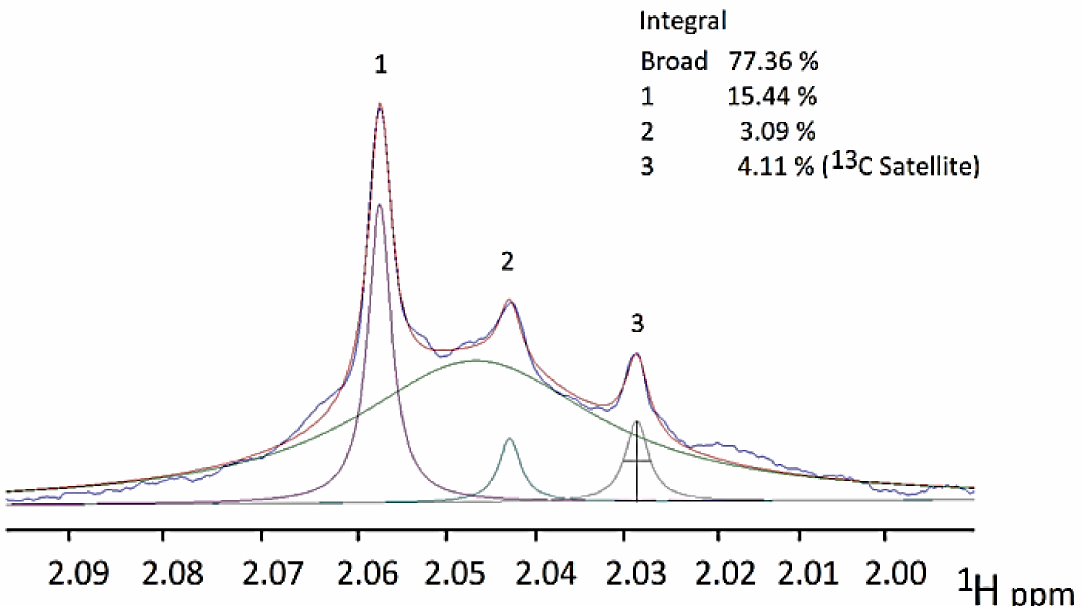
Figure 5. Deconvolution of the 1 H NMR Resonances of Salivary APP Side-Chain N-Acetylsugar Residues. Deconvolution line-fit of the signals present within the 1.99–2.10 ppm acetamido-CH 3 group region of the 600 MHz 1 H NMR profile of a typical human WMSS sample, which was achieved using Jeol Delta-5 software modelling. This deconvolution approach yielded a single major broad resonance ( δ = 2.046 ppm) presumably ascribable the GlycA signal detectable in human blood plasma, and three sharper ones located at 2.059, 2.042 and 2.028 ppm (labelled 1, 2 and 3, respectively), which are assignable to free N-acetylneuraminate- and N-acetylglucosamine-NHCOCH 3 group